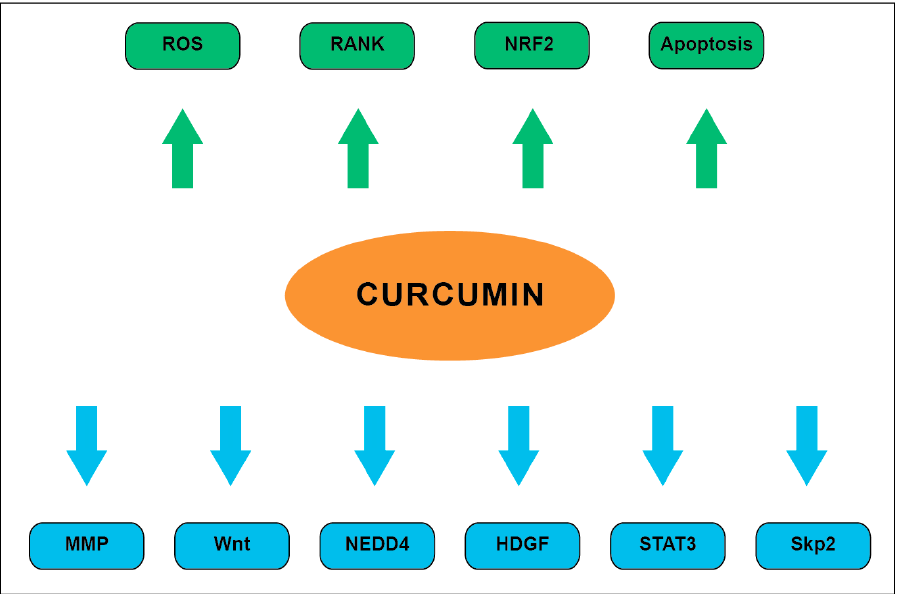
Figure 3. Summary of well described curcumin pharmacodynamics. Downregulated processes are denoted by blue arrows while upregulated processes are denoted by green arrows.